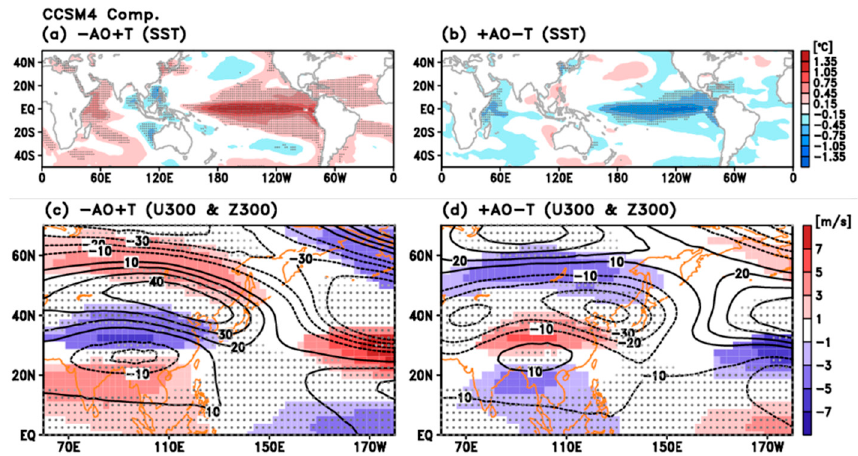
Figure 7. Composite maps of SST anomalies for ( a ) − AO + T and ( b ) + AO − T group in CCSM4 historical simulation. ( c ) and ( d ) are same as ( a ) and ( b ) but for zonal wind (shading) and geopotential (contours with interval 10m) anomalies at 300hPa. Gray dots denote grid points which satisfy 95% confidence level through the two-tailed Student’s T -test. Zonal wind in ( c ) and ( d ) is shaded only for the grids which satisfy 95% confidence